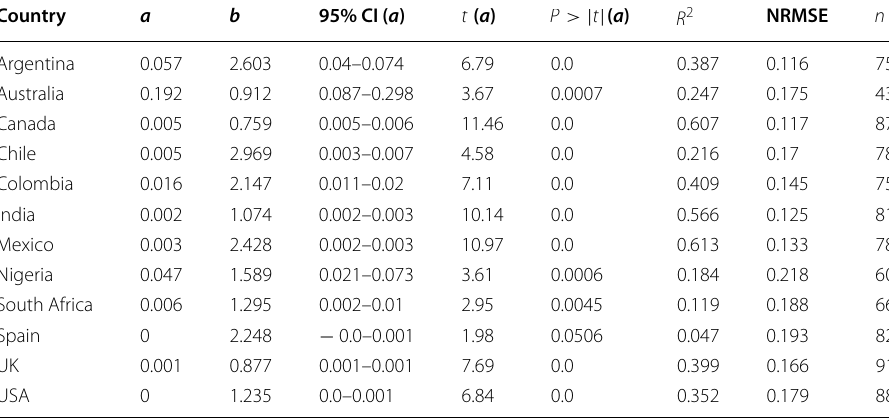
Table 6 Results for the linear model defined in Eq. (13)